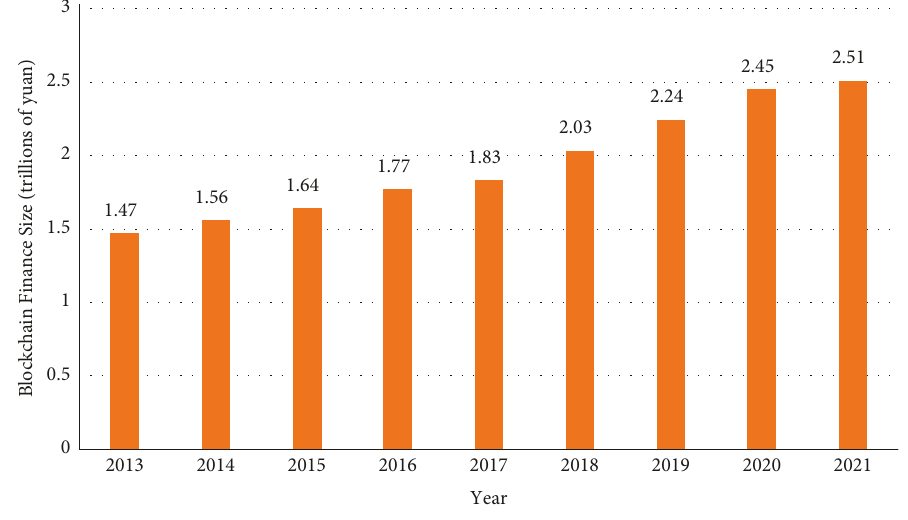
Figure 3: Blockchain financing size. Table 1: Public data from IT Orange database. Name of the firm Date of